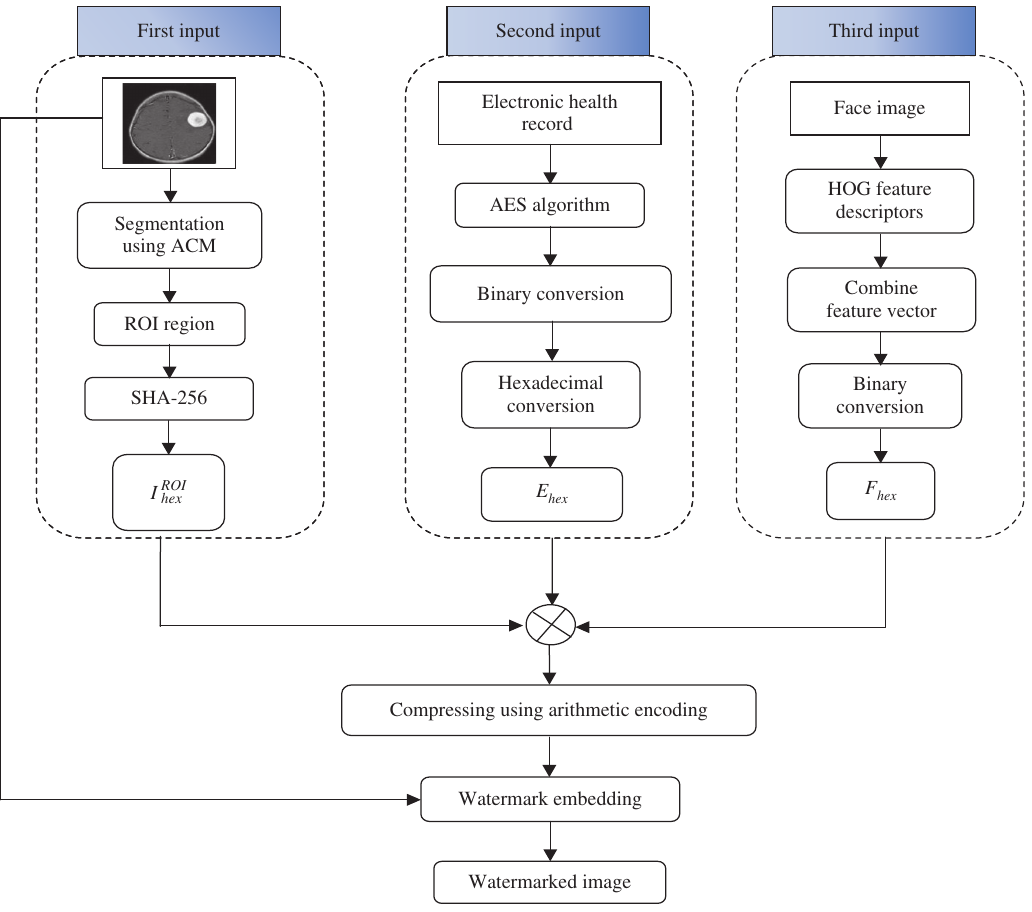
Figure 1: Proposed Crypto-Watermarking